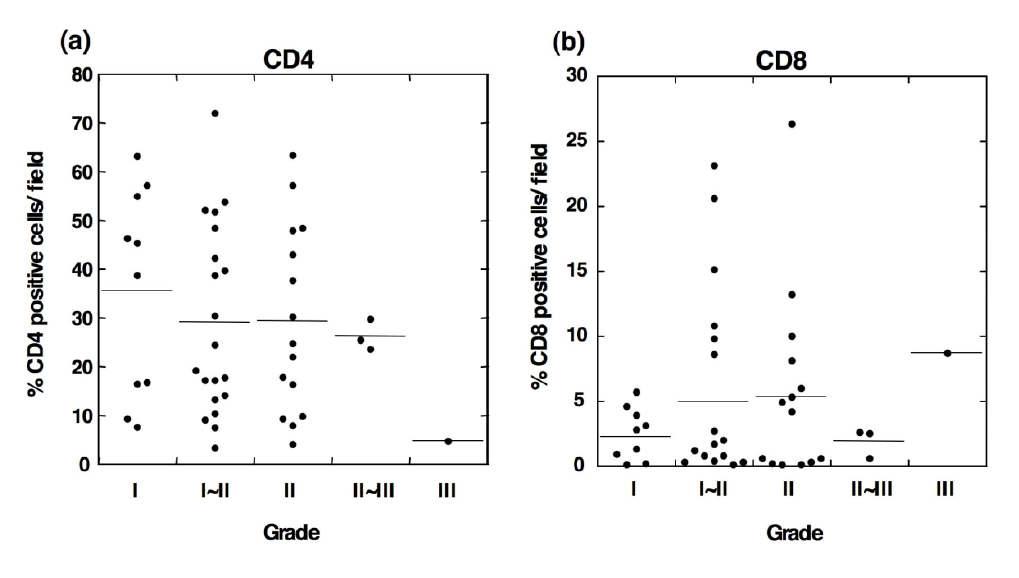
Figure 5. Analysis of infiltrating CD4- and CD8-positive cells in different histological grades of OSCC. Although CD4 + ( a ) and CD8 + ( b ) T cells were observed in OSCC, no statistically significant differences were observed among the different tumor